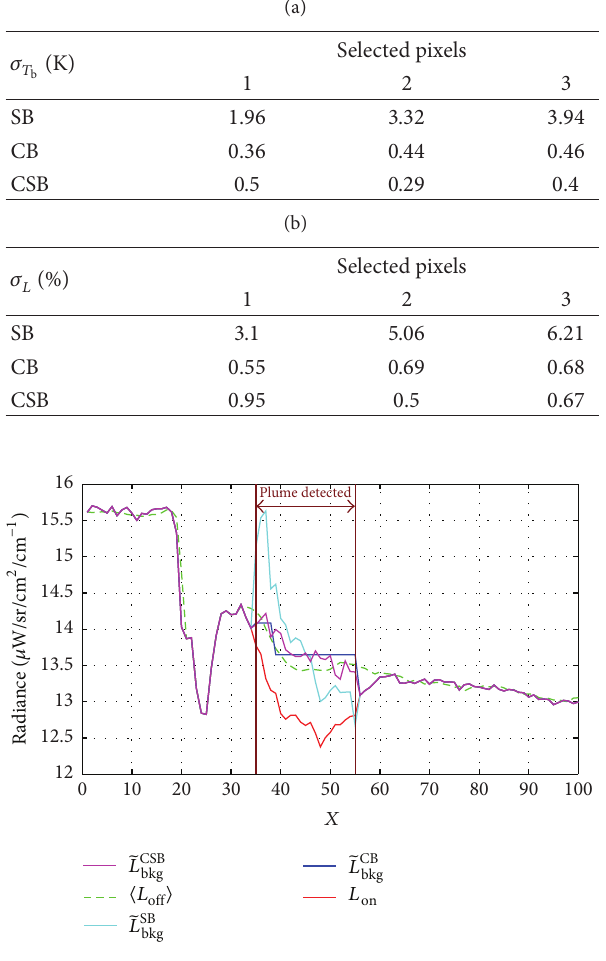
), while the second b